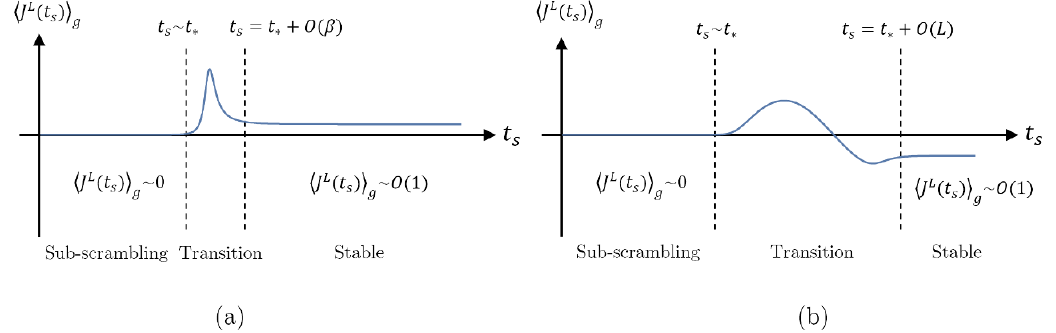
(cid:10) (cid:11) Figure 2 . The behavior of J L ( t s ) for three regimes of t s . (a) is a cartoon for (1.5) with transition g regime of length O ( (cid:12) ), and the resonant enhancement could be pronounced. (b) is for (1.6) with the size of the transition region of order O ( L ) for L (cid:29) (cid:12)